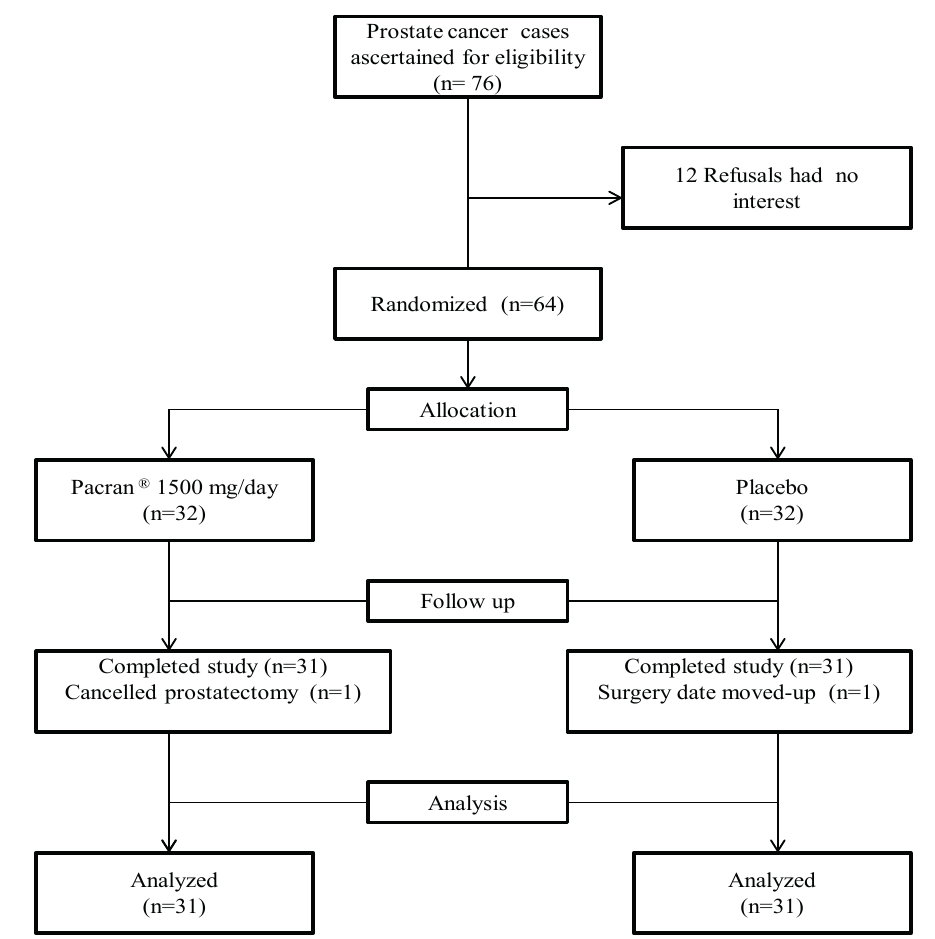
Fig. 1. CONSORT trial flow